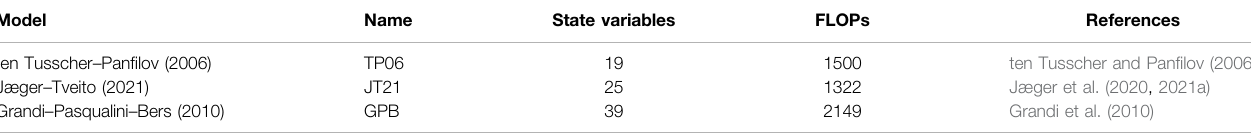
TABLE 1 | Cell models used in the numerical experiments of this paper. The “ FLOPs ” column lists the number of fl oating-point operations required to compute a single time step for a naïve implementation using the Forward Euler scheme. Section 3.2 describes how performance counters were used to obtain the operation counts.